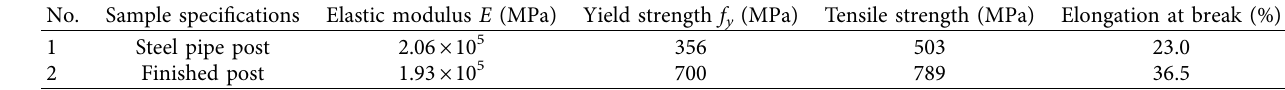
Table 2: Material properties of samples.